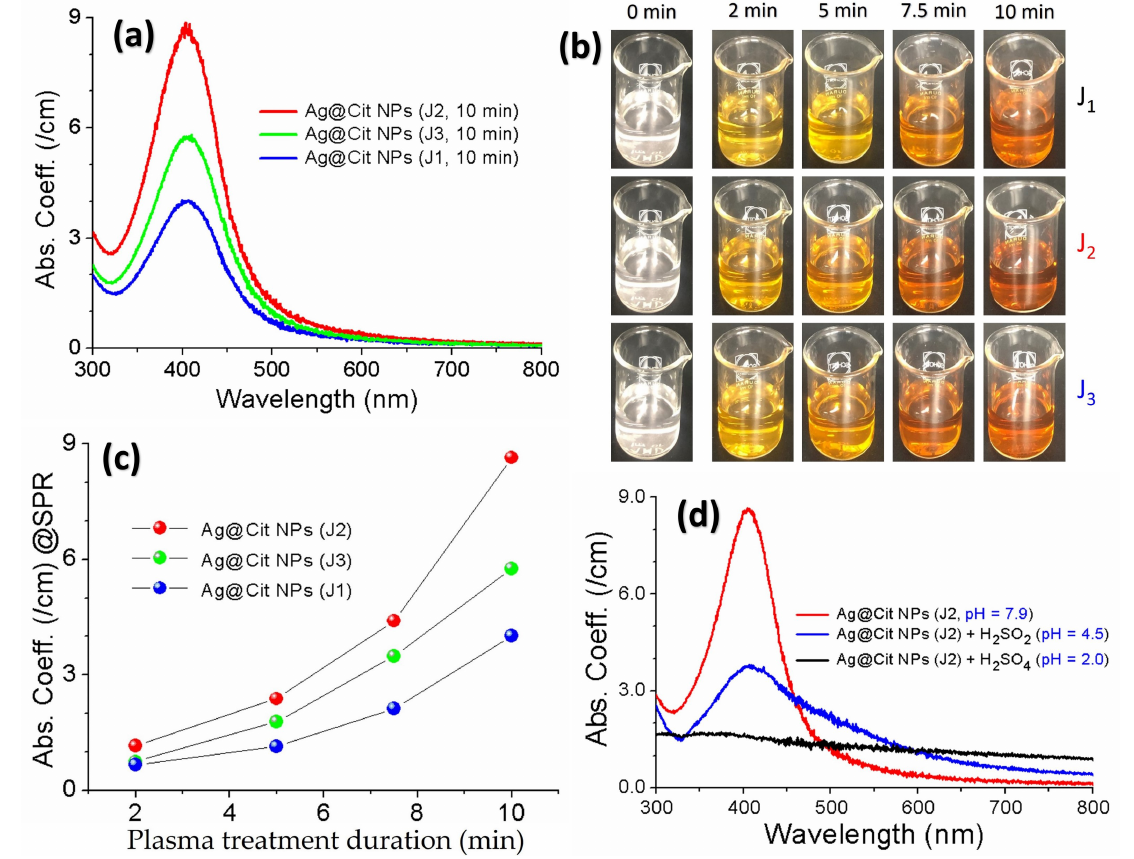
Figure 8. ( a ) Optical absorption spectra of the Ag@Cit NPs synthesized by treating AgNO 3 -TSC-DW for 10 min with the J1, J2, and J3 jets. ( b ) Color change of the plasma-synthesized Ag@Cit NPs over the plasma treatment durations of 2, 5, 7.5, and 10 min. ( c ) SPR peak intensity of the Ag@Cit NPs as a function of the plasma treatment duration. ( d ) Effects of acid treatments on the surface plasmon resonance absorption band of the Ag@Cit NPs synthesized with the J2 jet: H 2 SO 4 (pH = 2) and H 2 SO 4 (pH =